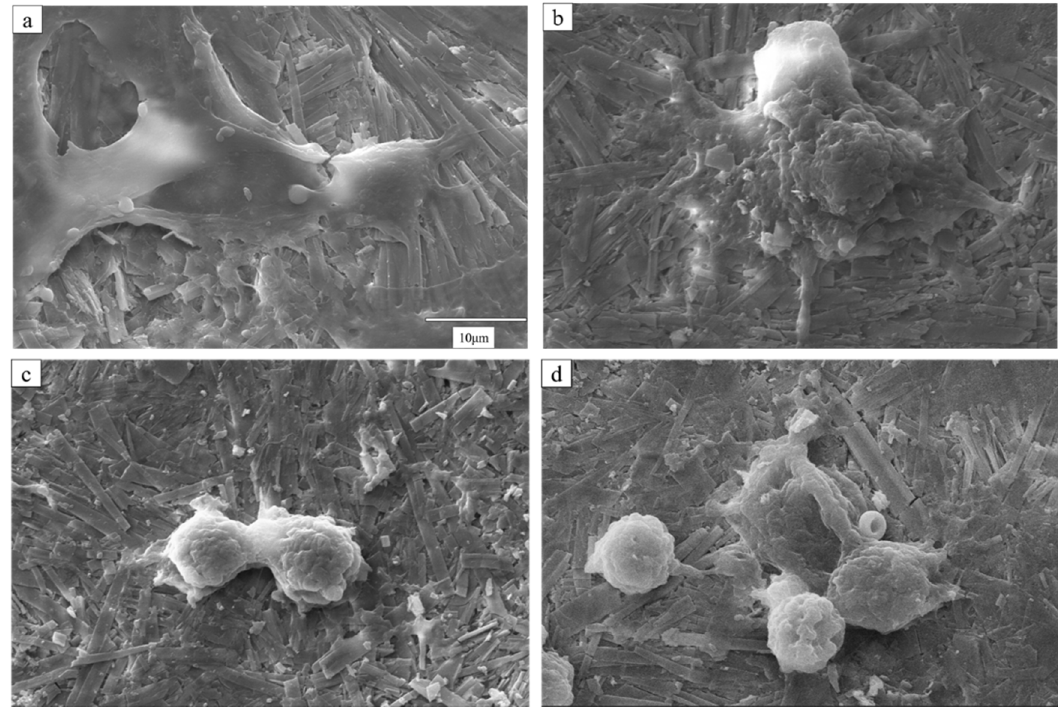
Figure 4. SEM images of MSCs cells after culturing for 3 days on ZnO/3Ag-HAw flakes.